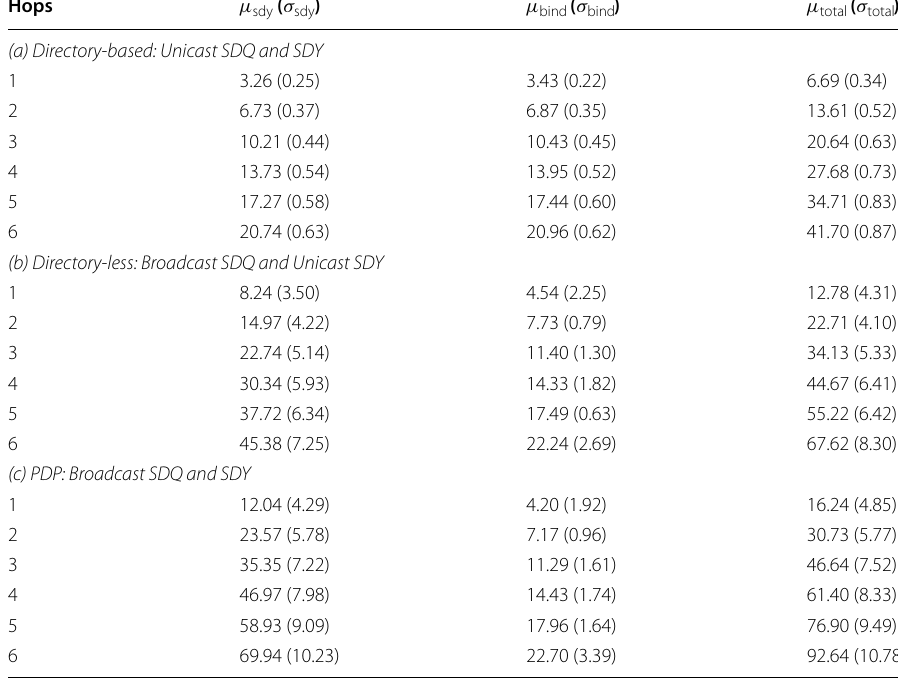
Table 2 Hops versus latency